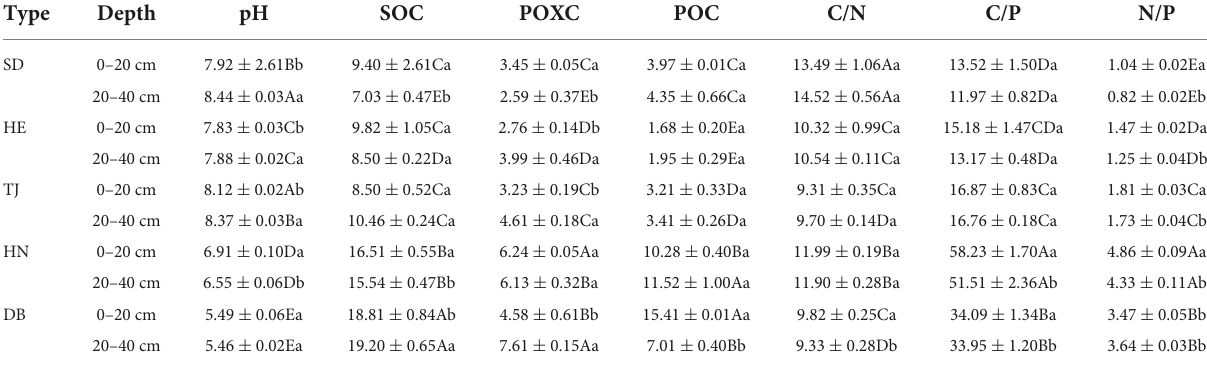
TABLE 1 Soil properties of different paddy soils.